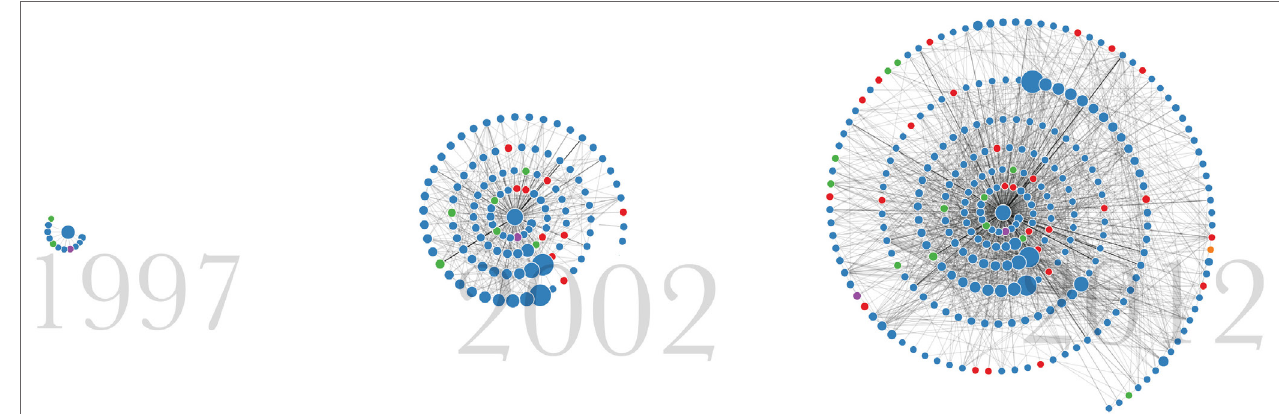
FigUre 1 | Three screenshots of the network animation as it builds over